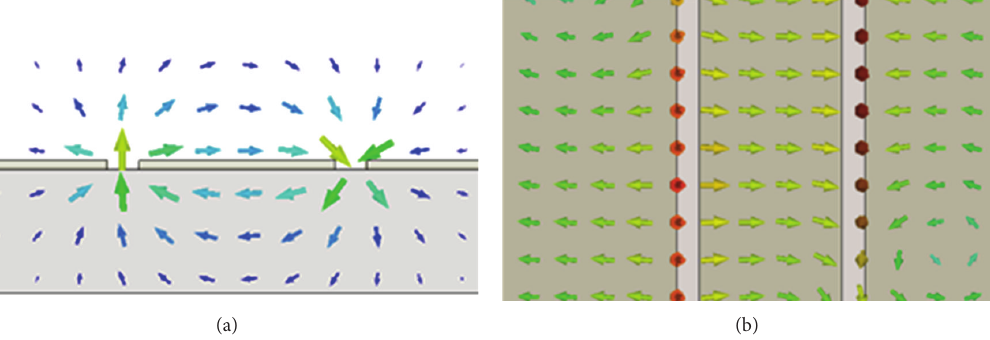
Figure 2: Simulated magnetic field distribution of the dominant mode in the cross view (a) and the top view (b) of the CPW.